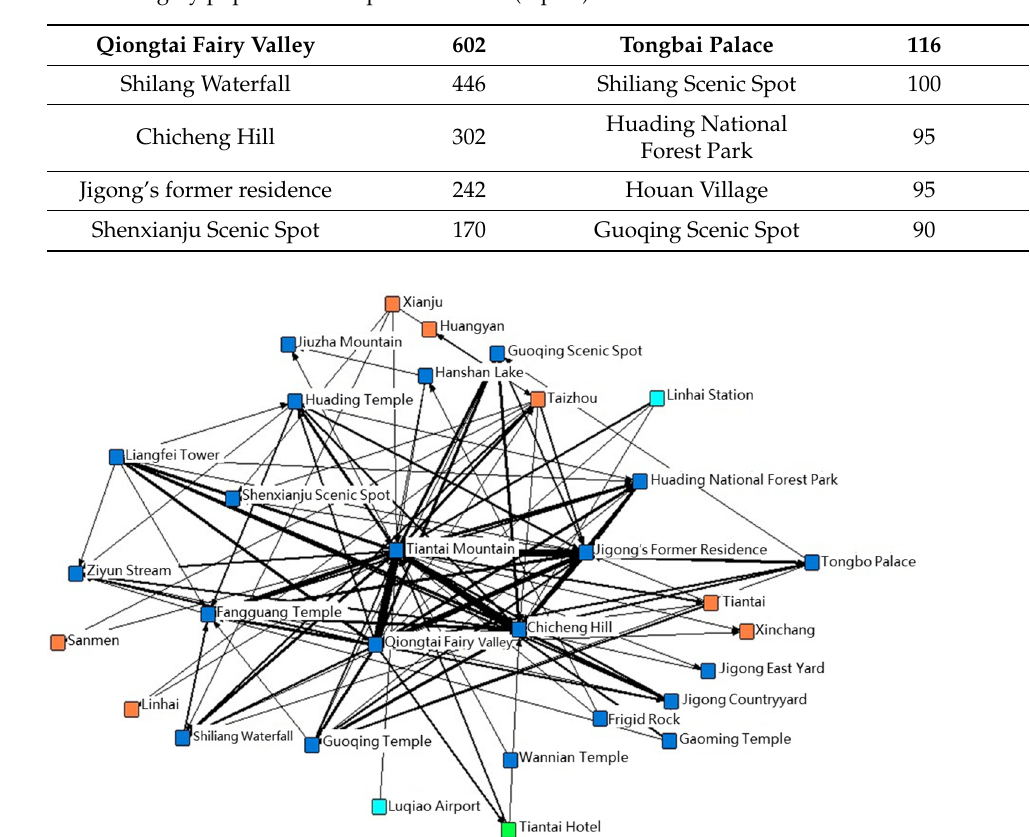
Figure 5. Co-occurrence network diagram of high-frequency tourist attractions in Tiantai.